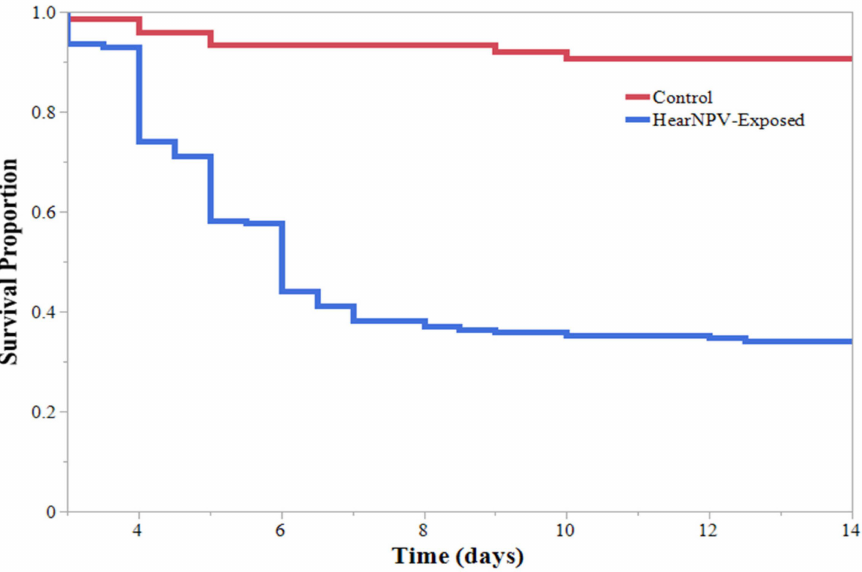
Figure 1. Helicoverpa zea (Lepidoptera: Noctuidae) Kaplan–Meier survival curves for all larvae of the initial infestation feeding on sprayed and unsprayed V3 soybeans, not accounting for differences in larval instars. Log-rank test: χ 2 = 59.032, p < 0.0001. Table 1. Determining the efficacy of Helicoverpa armigera nucleopolyhedrovirus (HearNPV) by investigating mortality, pupation, and time to mortality/pupation in Helicoverpa zea (Boddie) (Lepi- doptera: Noctuidae) larval instars when applied to V3 soybeans previously treated with HearNPV, and the time to mortality of a simulated 2nd infestation 14 days after the initial application (DAA).